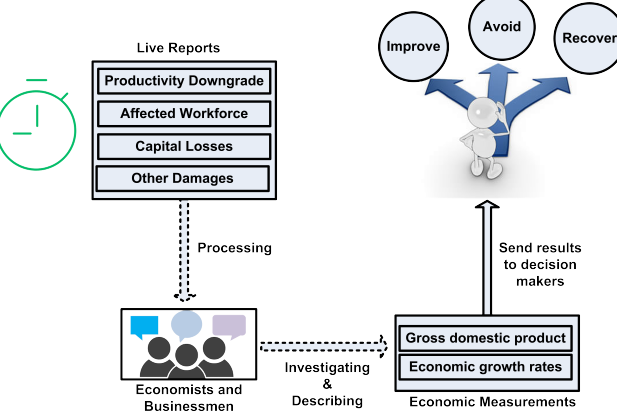
Figure 4. Real-time economic rates monitoring solution.